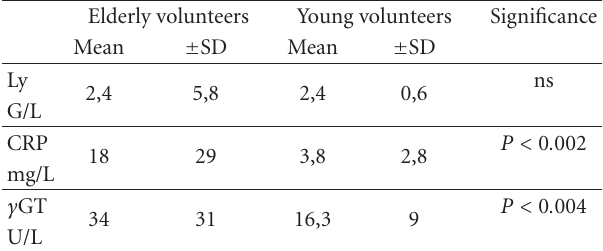
Table 2: Laboratory variables of elderly and young volunteers. Elderly